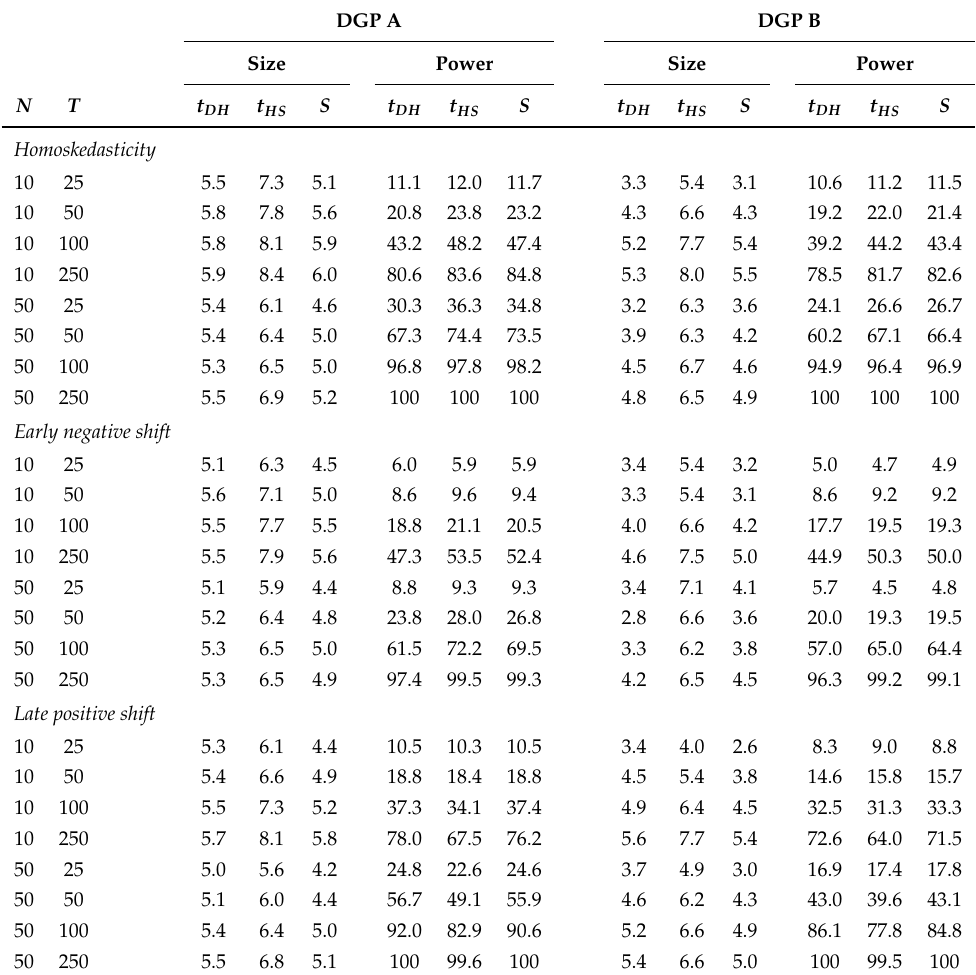
Table A2. Rejection frequencies in cross-dependent panels—spatial correlation. γ i ∼ iid U ( 0.9,1 ) , µ i ∼ iid U ( 0,0.02 ) , Θ = 0.8. DGP B: θ i ∼ iid U ( 0.2,0.4 ) . Power is computed using size-adjusted 5% critical values; 25,000 replications were